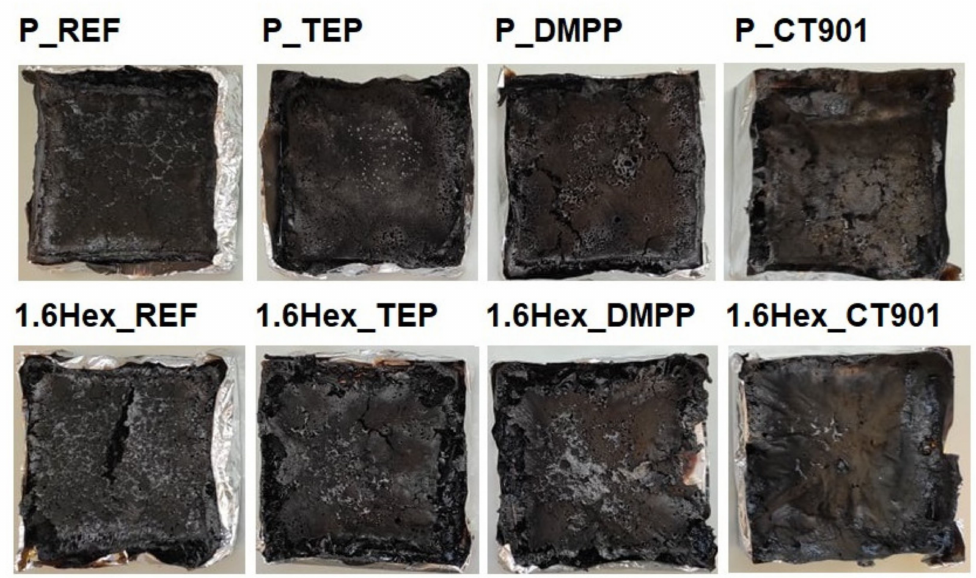
Figure 14. Photos of the samples after the cone calorimeter